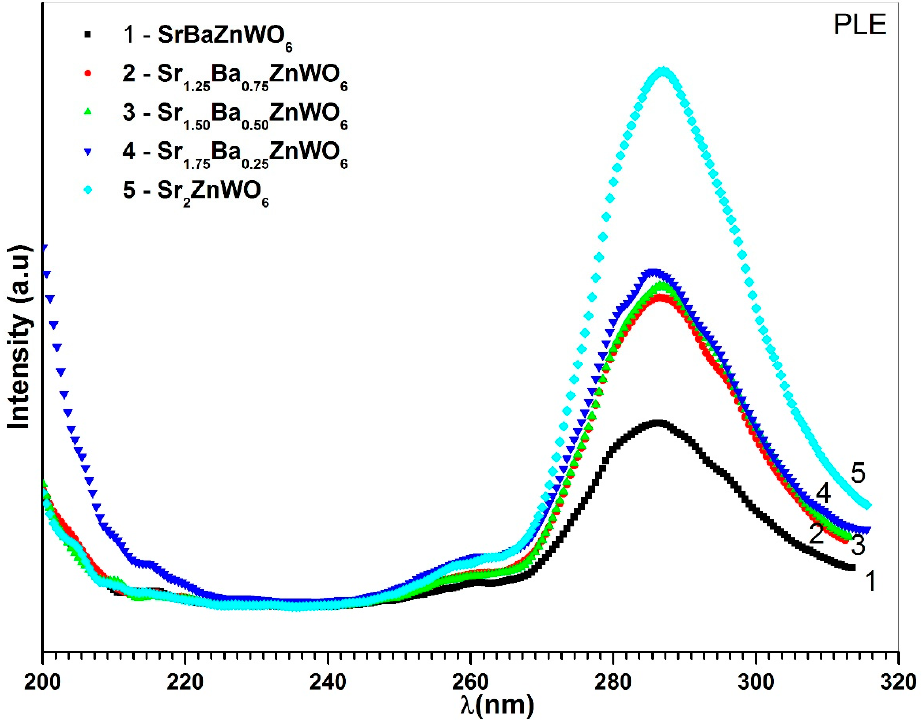
Figure 11. PLE of the Ba 2 − x Sr x ZnWO 6 (x = 1, 1.25, 1.50, 1.75, 2) double perovskite series.